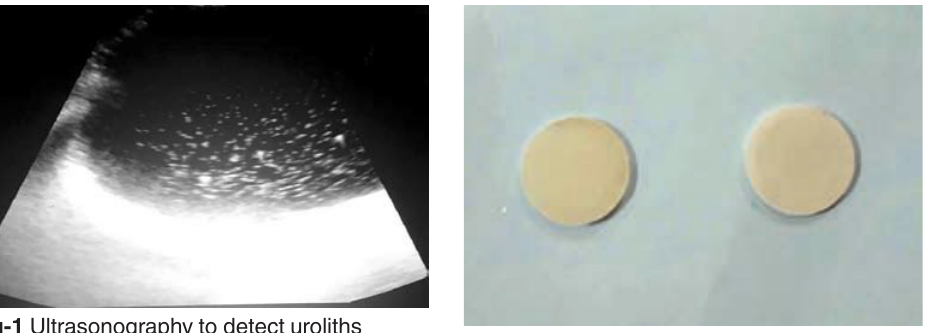
Fig-3 Prepared pellets of KBr and urolith for FTIR – ATR spectroscopy